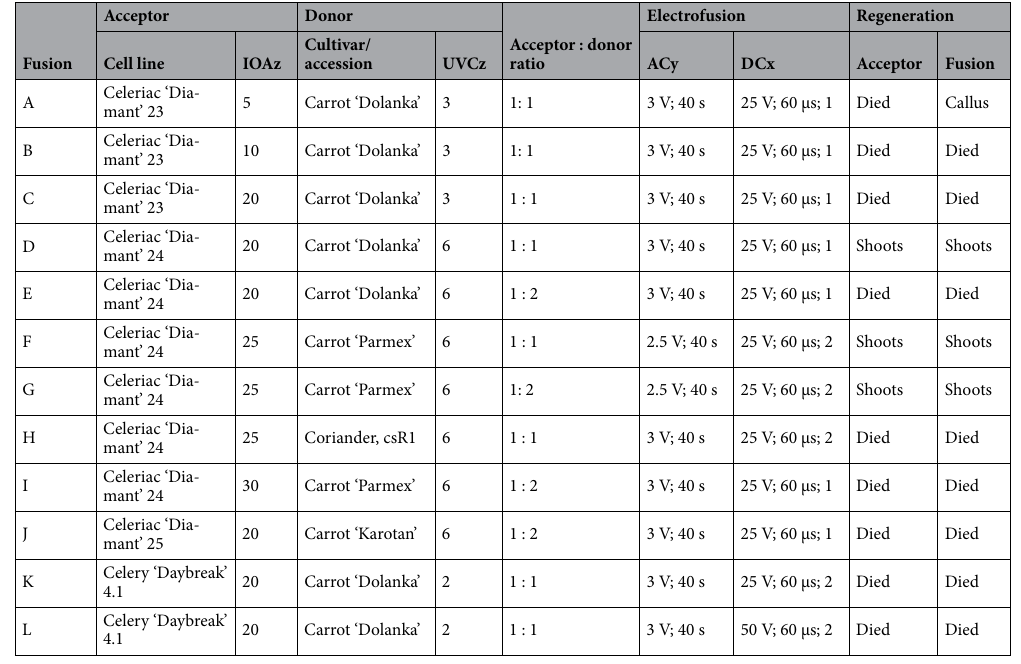
Table 3. Overview of parameters applied in the electrofusion of experiment 4. Per electrofusion the regeneration status of the IOA control and the fusion samples, 16 weeks after the start of the culture, is shown. z Exposure time (min). y Alternating current: alignment voltage; alignment duration. x Direct current: pulse voltage; pulse duration; number of pulses.